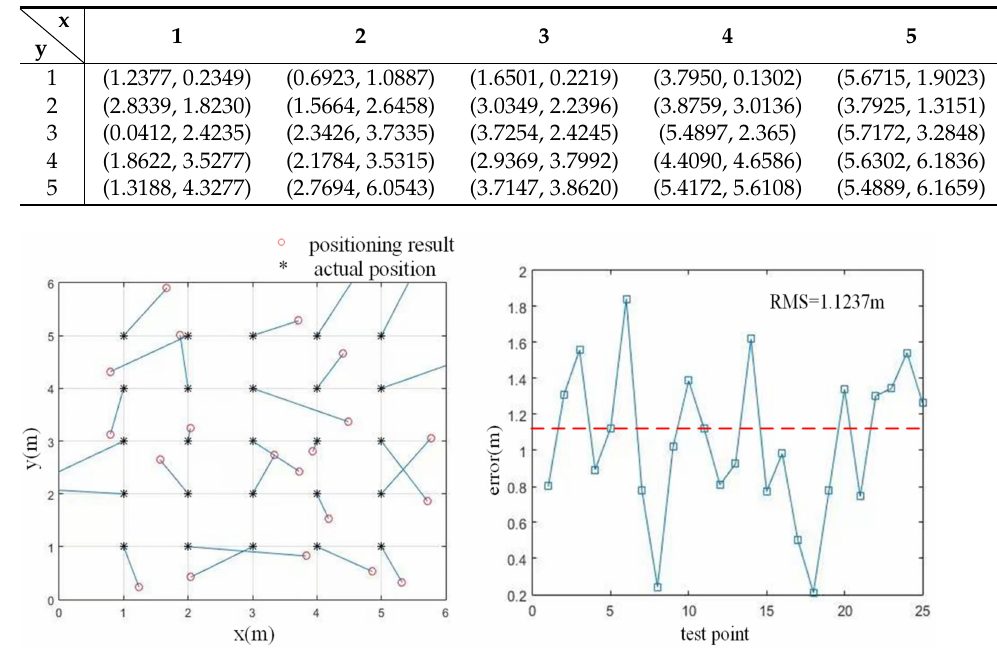
Figure 14. Positioning results of the area without collected